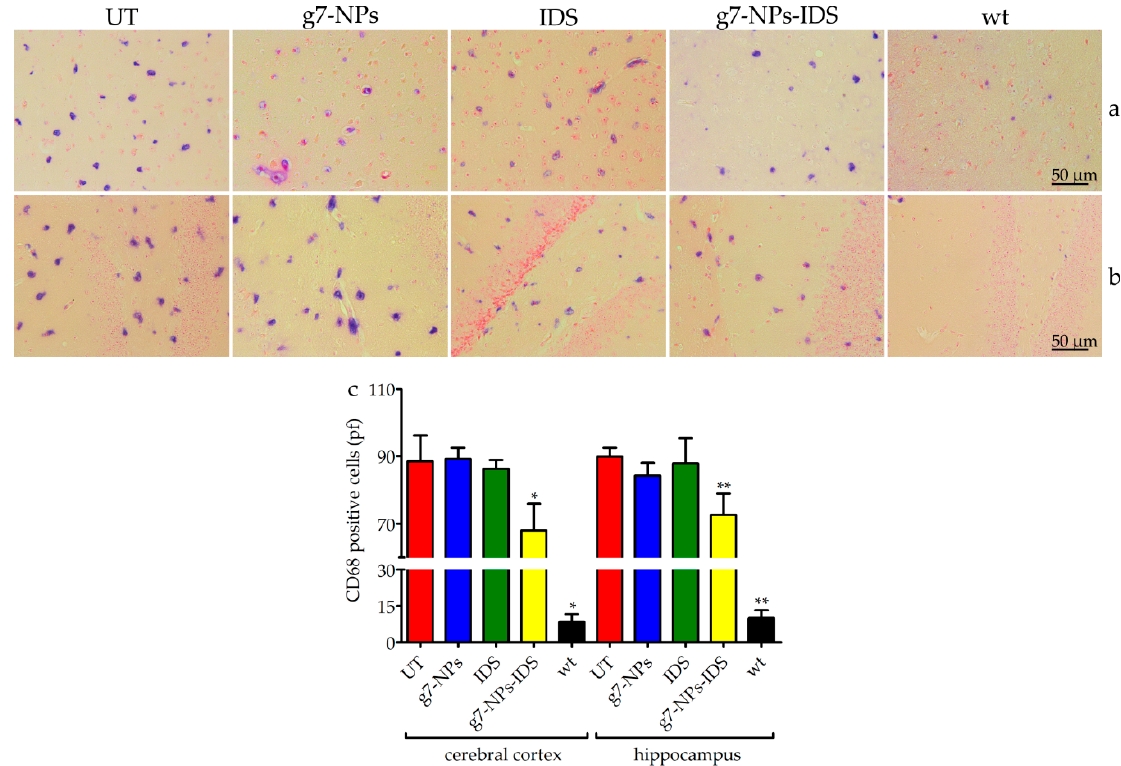
Figure 5. Immunohistochemical analysis of CD68 in the brain. Immunohistochemical analysis of CD68 in Ids-ko mice treated with 0.9% NaCl (untreated, UT), g7-NPs, free IDS, g7-NPs-IDS, and in wt mice, after 6 weeks of treatment. Representative images of ( a ) cerebral cortex and ( b ) hippocampus of 7 µ m sections stained with CD68 antibody (purple spots) and counterstained with 0.5% Eosin Y solution. ( c ) Quantification of positive cells to CD68 in the cerebral cortex and hippocampus. n = 5 mice / group, pf = per field. All data are mean ± SD. Asterisks indicate a statistically significant di ff erence from UT mice (Mann–Whitney U test, * p < 0.05, ** p < 0.01). All Ids-ko mice groups presented a statistically significant di ff erence from wt